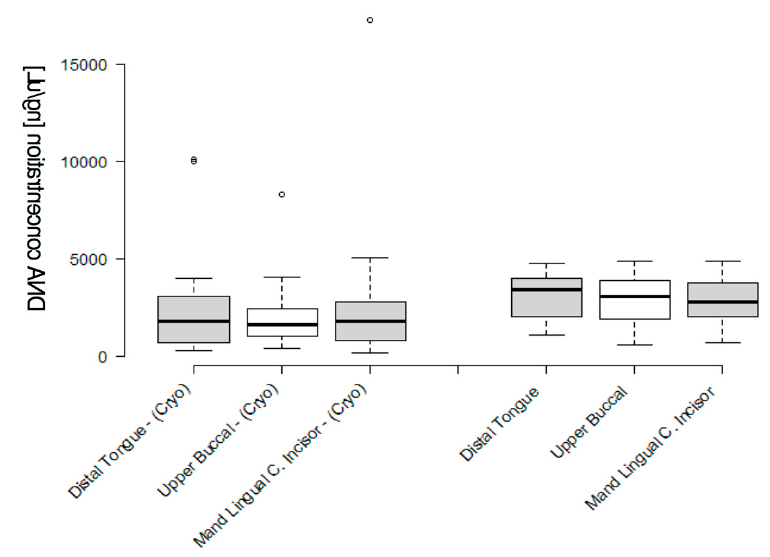
Figure 3. Comparison of the DNA concentrations isolated from the frozen and original (fresh) biofilm samples. Graphic display of representative samples ( n = 10) demonstrated a slightly broader range of DNA concentrations among the original (fresh) samples compared with cryopreserved samples, with higher averages among the original (fresh) samples. Original (fresh): 2927.3 ng / µ L and cryopreserved: 2286.5 ng / µ L ( p = 0.0308).